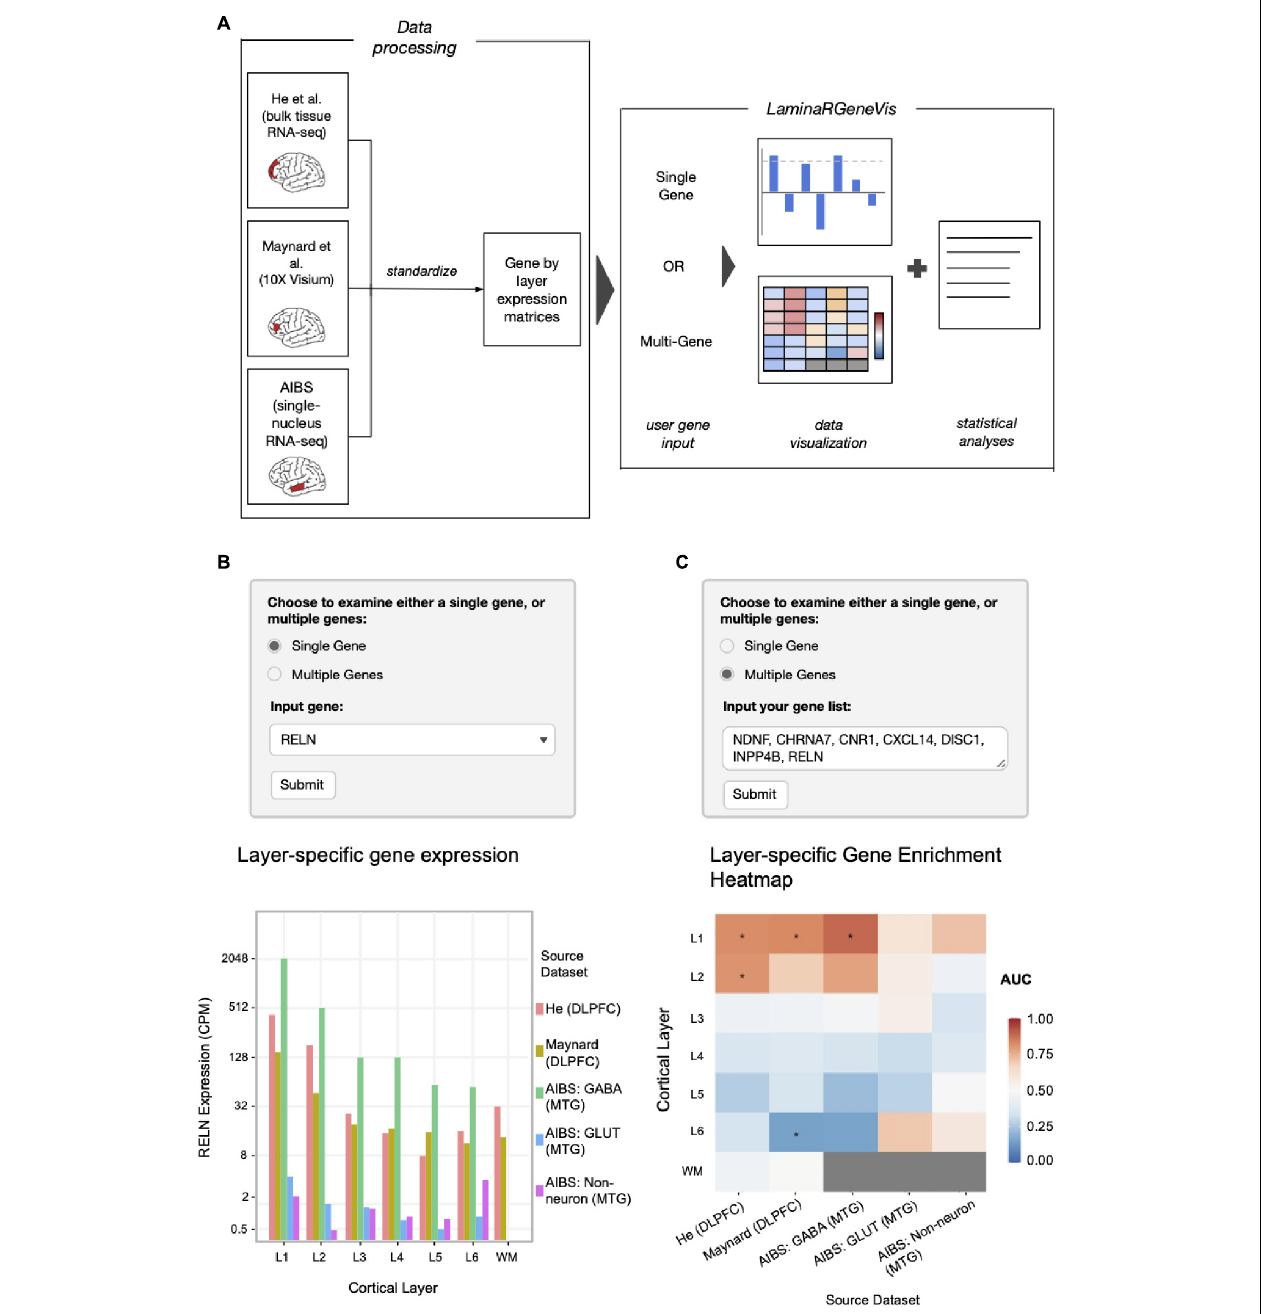
FIGURE 2 | (A) Overview diagram of the data processing steps and web application interface combined. (B) Example single-gene input settings and output for RELN expression (CPM on a log scaled y -axis) across the cortical layers and white matter with color marking the source datasets and cell types. (C) Example multi-gene input settings and heatmap visualization output for genes found to mark layer 1 in a separate study of laminar expression patterns (Zeng et al., 2012). Cells are colored according to the enrichment of layer-specific expression of the input genes (AUC scores). P -values were calculated using the Mann-Whitney U test and adjusted for multiple test correction through Bonferroni correction; asterisks (*) indicate p corrected <